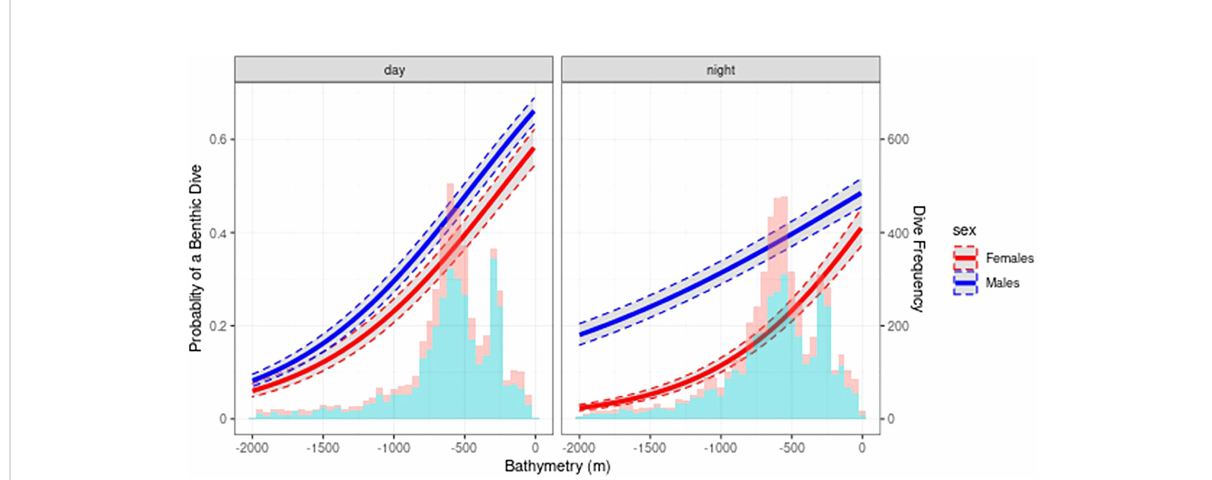
FIGURE 5 The probability of an elephant seal performing a benthic dive on the Kerguelen Plateau during their post-molt time at sea, with respect to bathymetry, time of day and sex. The solid lines represent the predicted values from a GLMM (dive Type~sex*bathymetry*time of day, with seal ID as a random term), and the dotted lines the 95% con fi dence limit of those predictions. The histograms in the background indicate the frequency distribution of bathymetric values used in the